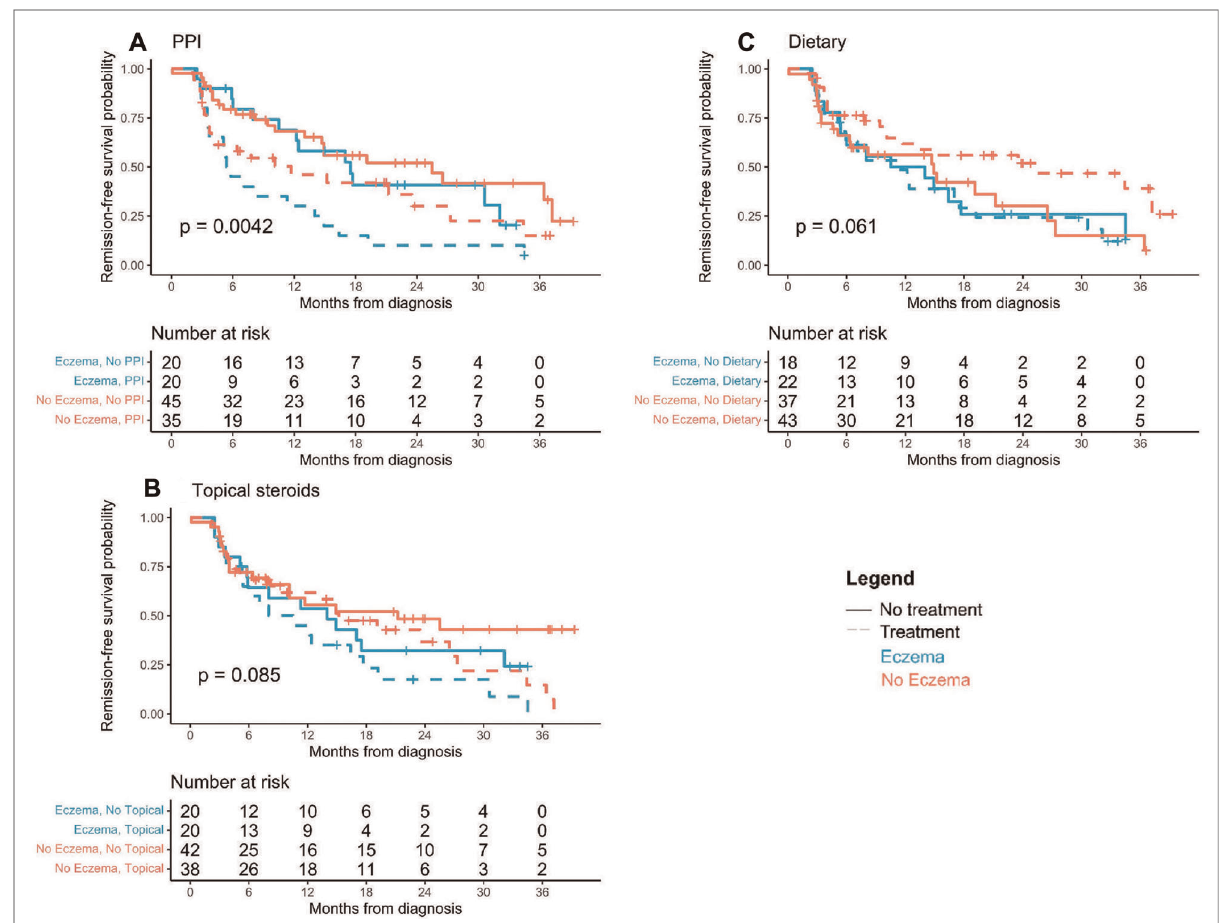
FIGURE 4 ( A – C ) Time to fi rst remission by last full treatment tried. Kaplan-Meier curves of time until fi rst histologic remission by treatment type and eczema status. Children that did not experience histologic remission by 3 years post-diagnosis were censored at their last available EGD